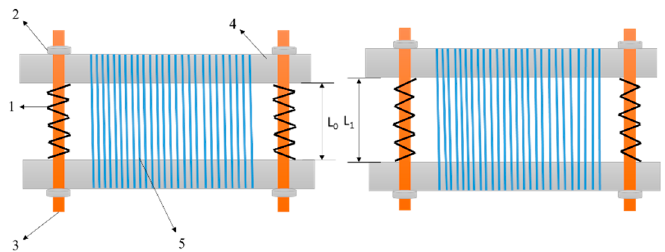
Figure 1. Tension application instrument: (1) Spring; (2) nut; (3) screw; (4) semicircular stainless-steel tube; (5) polyacrylonitrile (PAN) fibers; L 0 : Spring length after loosening the nut; L 1 : Spring length after reaction.